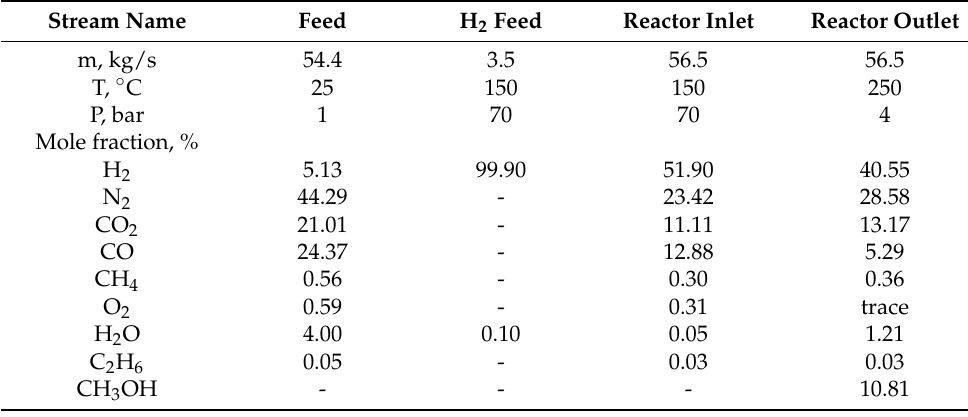
Table A3. Stream results of the combined case—MeOH